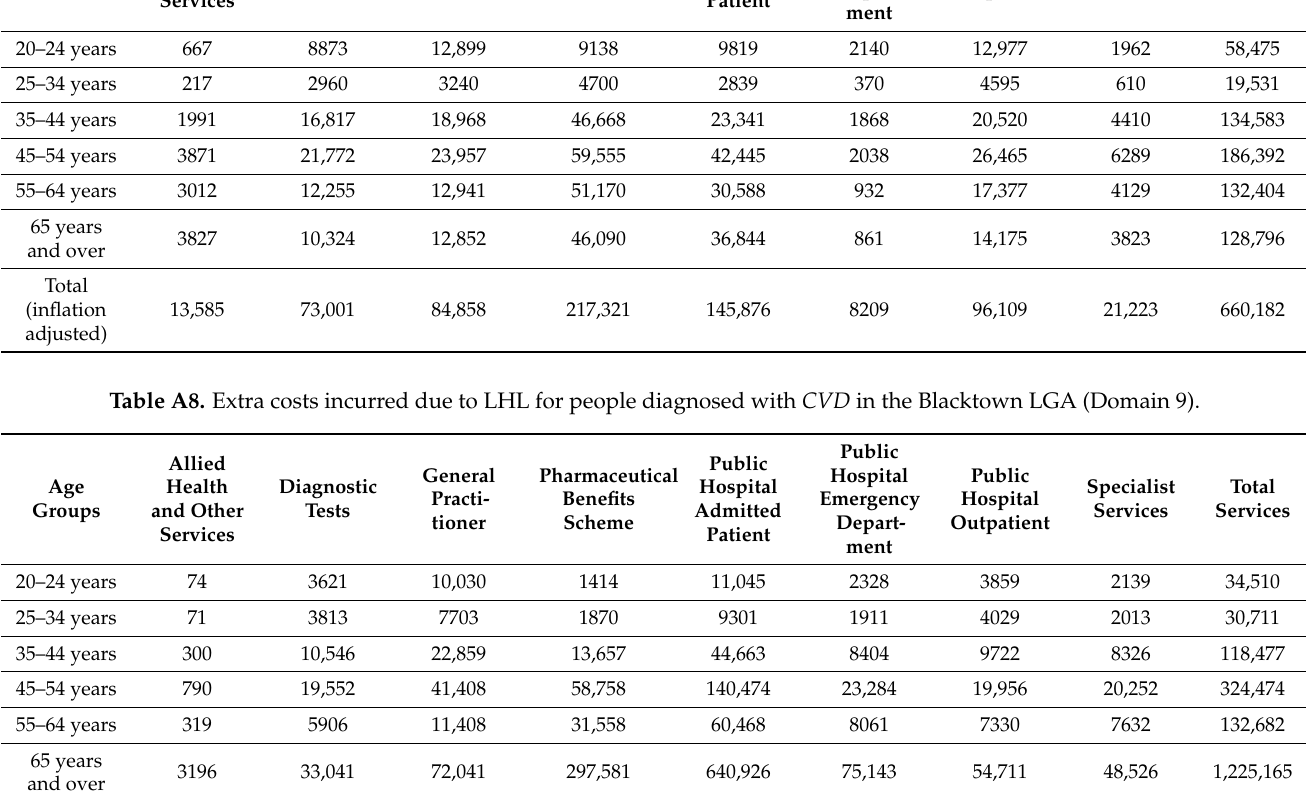
Table A7. Extra costs incurred due to LHL for people diagnosed with Endocrine disorders in the Blacktown LGA (Domain 6). Allied Age Health Groups